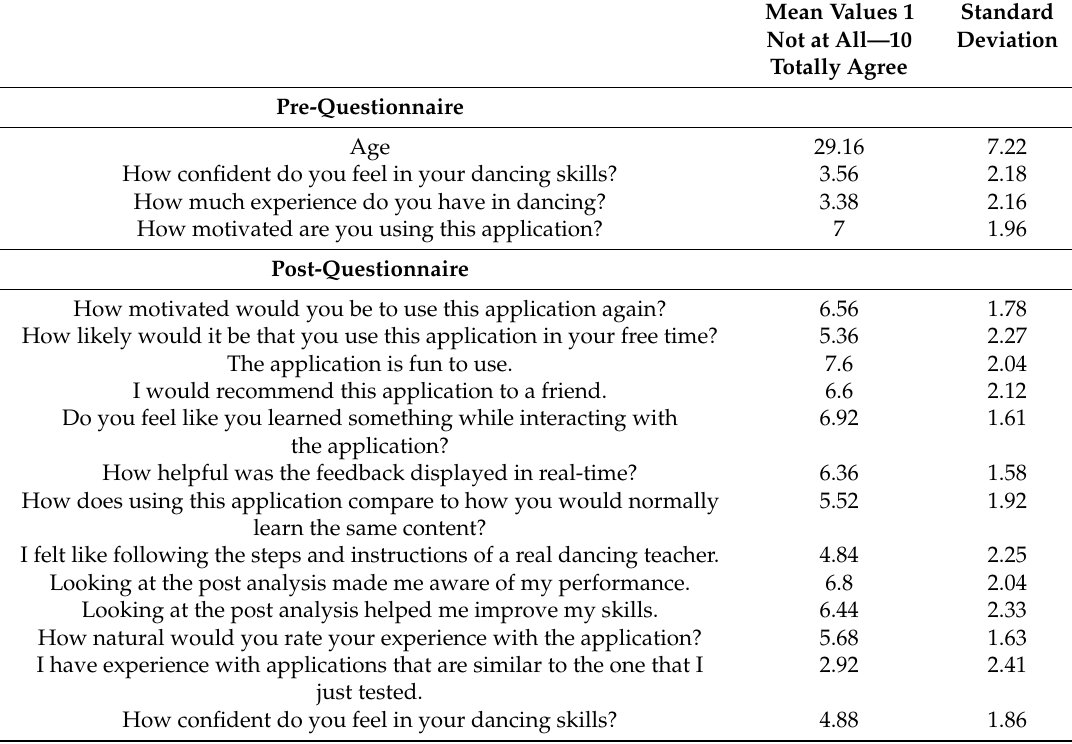
Table 6. Results from the pre- and